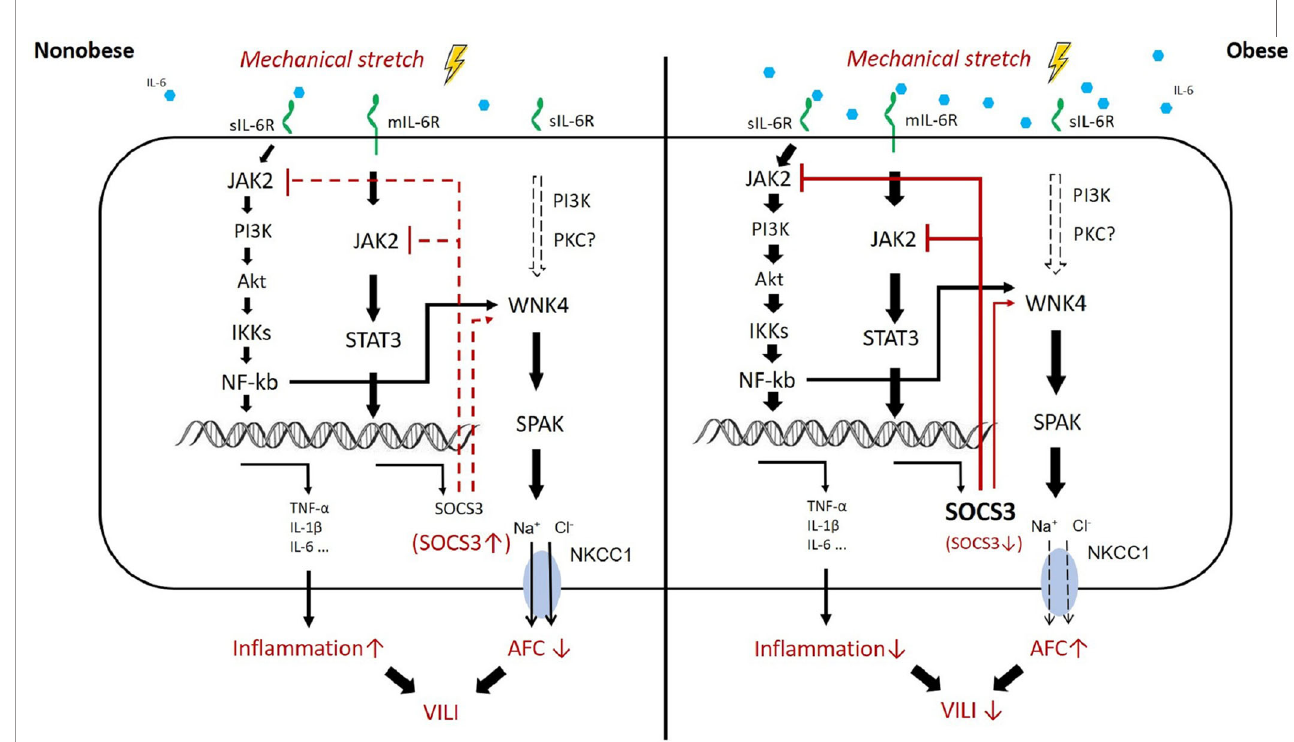
FIGURE 9 | Proposed mechanism of obesity-mediated attenuation of ventilator-induced lung injury. In obesity, higher circulating levels of IL-6 result in the activation of JAK2 – STAT3/NF k B and overexpression of SOCS3 at the baseline status, the so-called chronic in fl ammation. The upstream pathway of WNK4 includes NF k B, SOCS3, and possibly PKC. These proteins also account for the baseline upregulation of WNK4 in obesity. After mechanical stretching (brown color), signal transduction via JAK2 is hindered immediately by the existing SOCS3 overexpression in obesity. Subsequently, the inhibition of JAK2 signaling retards the STAT3 – SOCS3 and NF k B cascades and the WNK4 axis. Eventually, VILI is also attenuated.